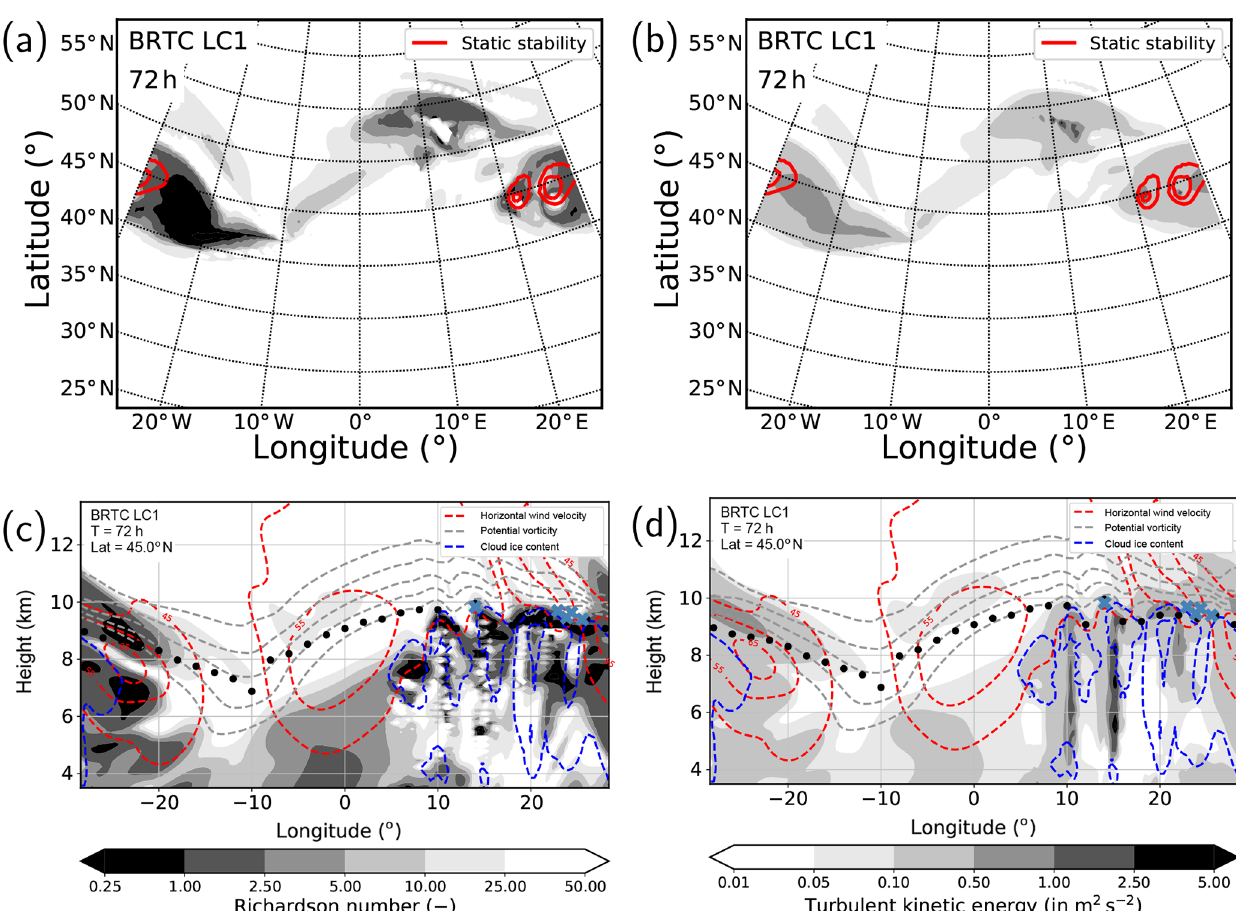
Figure 13. Panels (a) and (c) show gradient Richardson number, Ri , panels (b) and (d) TKE after 72h of model integration. Panels (a) and (b) show a horizontal cross section at the dynamic tropopause along with isolines of static stability with values of N 2 = 5 . 5 × 10 − 4 s − 2 and N 2 = 7 . 0 × 10 − 4 s − 2 ; panels (c) and (d) show zonal cross sections at 45 ◦ N in the center of the model domain, including isolines of various variables (see detailed description in Fig.